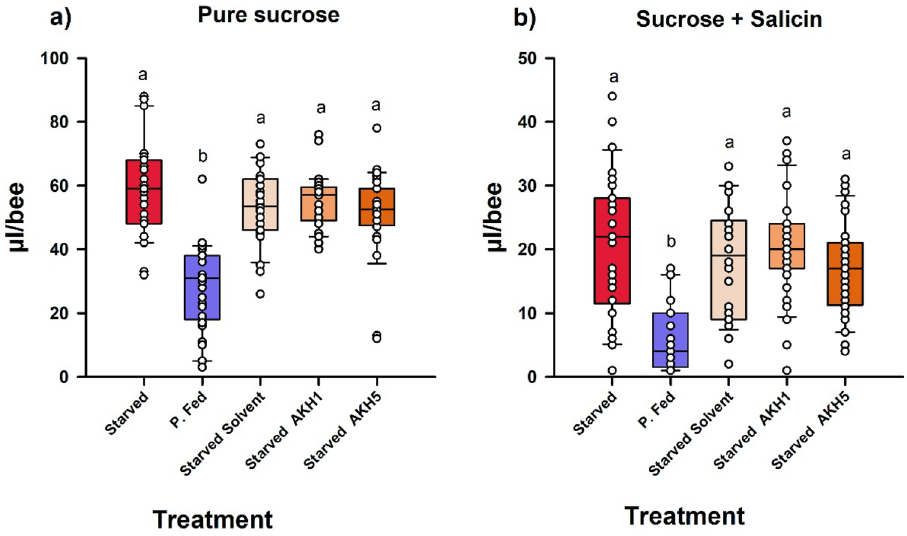
Figure 3. Ingestion (µl/bee) of starved foraging bees treated or not with AKH, when presented with a pure 0.6 M sucrose solution ( a ) or a 0.6 M sucrose solution spiked with 100 mM salicin ( b ). Food was provided 30 min after the topical treatment. Bees were either starved (‘Starved’) or partially fed (‘P. Fed’) with a honeydew diet. P. Fed bees and one group of Starved bees were left untreated. One group of starved bees was topically exposed with solvent (‘Starved solvent’). The other two groups of starved bees were topically exposed with AKH 1 µg/µl (‘Starved AKH1’) or AKH 5 µg/µl (‘Starved AKH5’). ( a ) Consumption of pure 0.6 M sucrose solution. Thirty min after topical treatment, starved bees consumed significantly more 0.6 M sucrose solution than partially fed bees (n = 29). Starved (n = 29), Starved solvent (n = 30), Starved AKH1 (n = 29) and Starved AKH5 bees (n = 28) did not differ in their consumption of sucrose solution. ( b ) Consumption of 0.6 M sucrose solution spiked with 100 mM salicin solution. Thirty min after topical treatment, starved bees consumed significantly more sucrose solution spiked with salicin than partially fed bees. Yet, consumption decreased significantly in all groups compared to the situation in which pure sucrose solution was offered (note the different ordinate scale in ( a,b ), which was changed to appreciate data dispersion), thus showing the unpalatable nature of the mixture offered. Partially fed bees (n = 29) consumed significantly less mixture than starved bees. Starved (n = 30), Starved solvent (n = 26), Starved AKH1 (n = 31) and Starved AKH5 bees (n = 32) did not differ in their consumption of sucrose solution. These results show that AKH did not affect the ingestion behavior of starved bees. In both panels, data shown are the median (horizontal line) and the 10th, 25th, 75th and 90th percentiles as vertical boxes with error bars and the corresponding overlaid scatter plots. Different letters above boxes indicate significant differences (P <